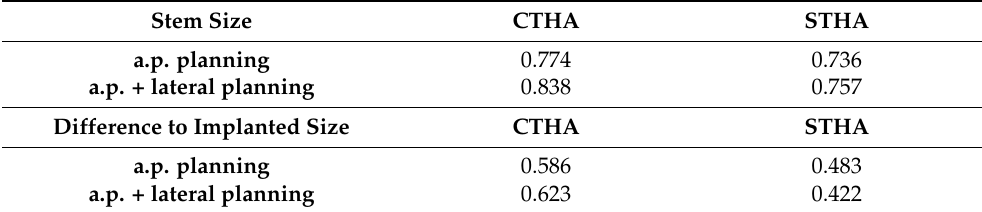
Table 2. The intra-class correlation ICC (3,1) with a consistency of the values between all three